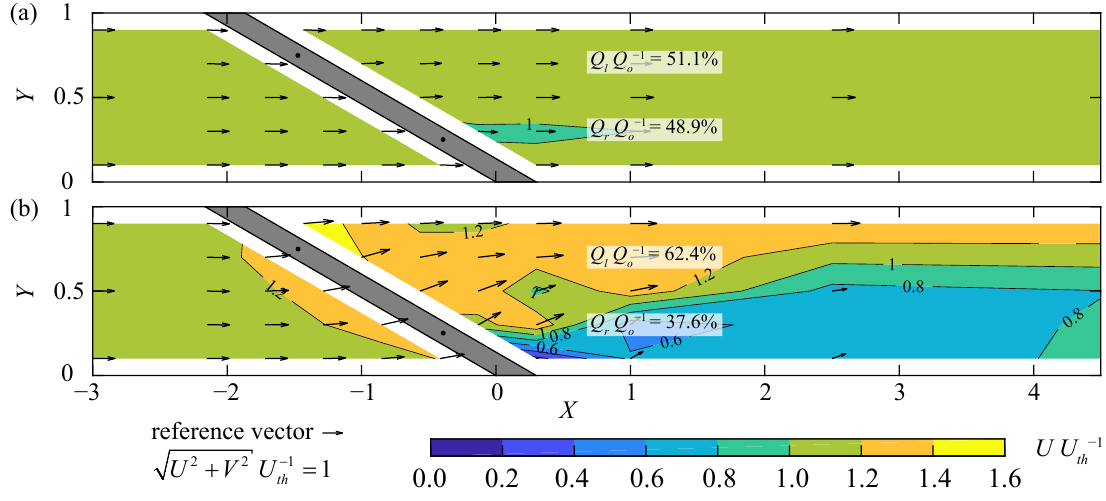
Figure 8. Velocity field at Z = 0.5 for S4, α = 30, s b = 20 mm for ( a ) H Bo = H To = 0 ( ξ R = 0.23) and ( b ) H Bo = H To = 0.2 ( ξ R = 1.01); note the changed contour map scaling in comparison to Figures